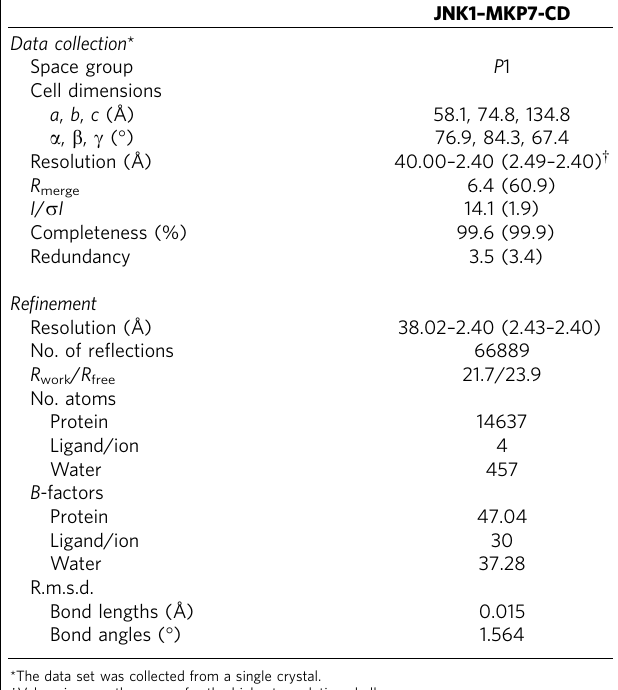
*The data set was collected from a single crystal. w Values in parentheses are for the highest resolution